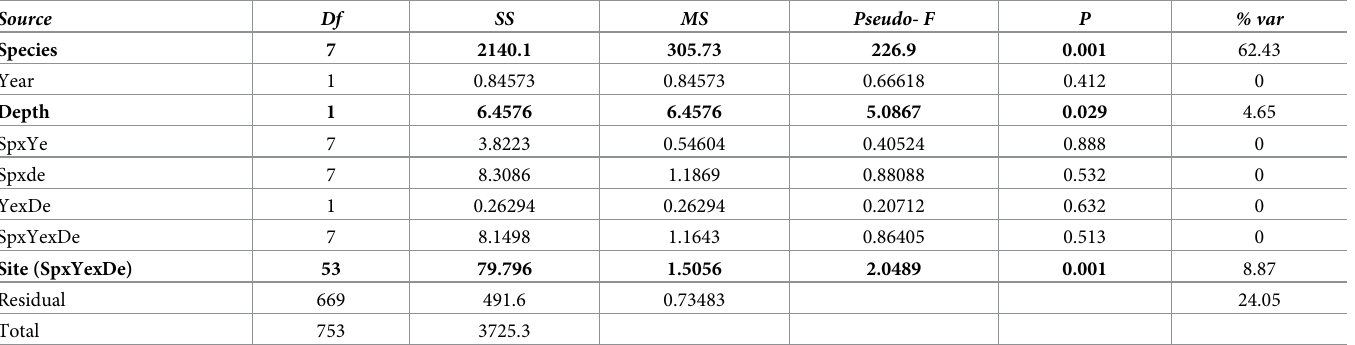
Table 3. PERMANOVA testing for the effects of species, year and depth on the Mg content in calcite. The design included the fixed factors (species, year and depth) and site nested in the combination of species, year and depth. PERMANOVA was done on untransformed skeletal Mg-calcite using a Euclidean distance similarity matrix. % var = Estimates of components of variation of Mg content in calcite for each factor in the analysis. Bold type indicates significant difference at p =